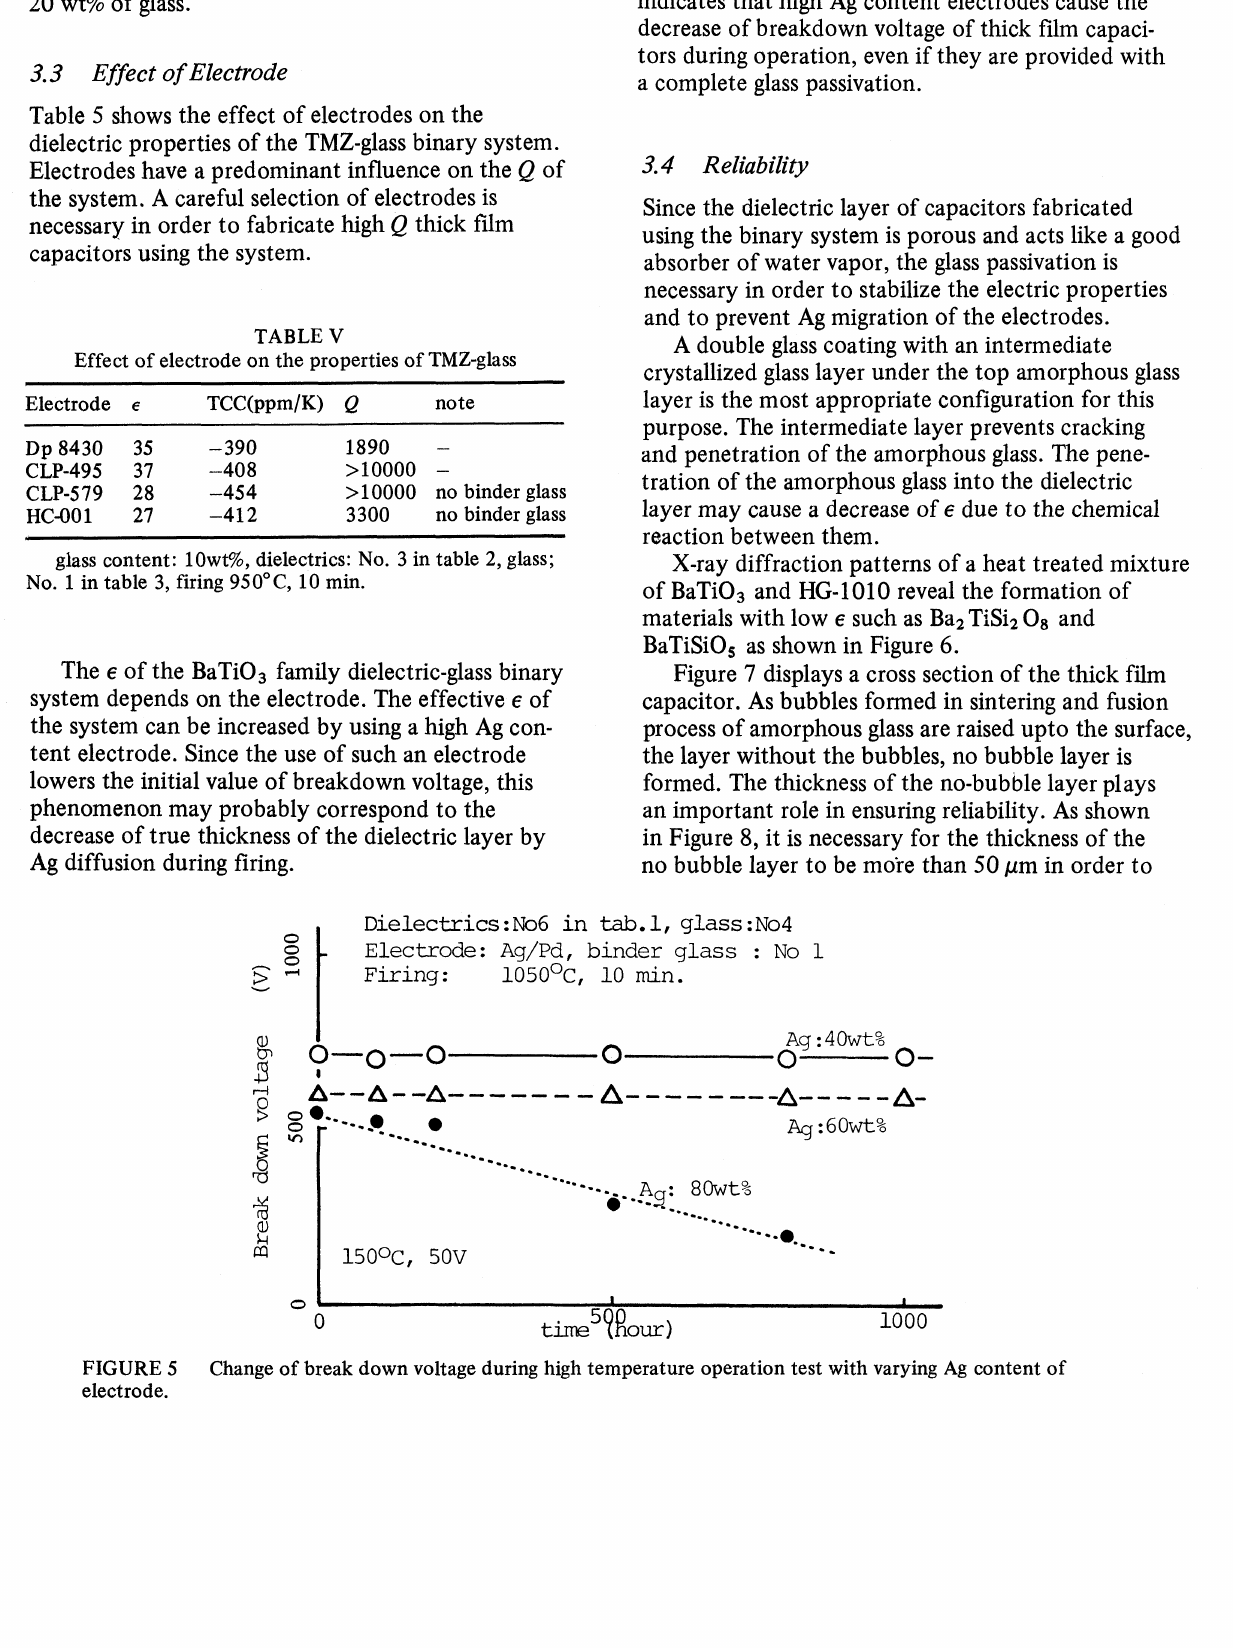
FIGURE 5 electrode.